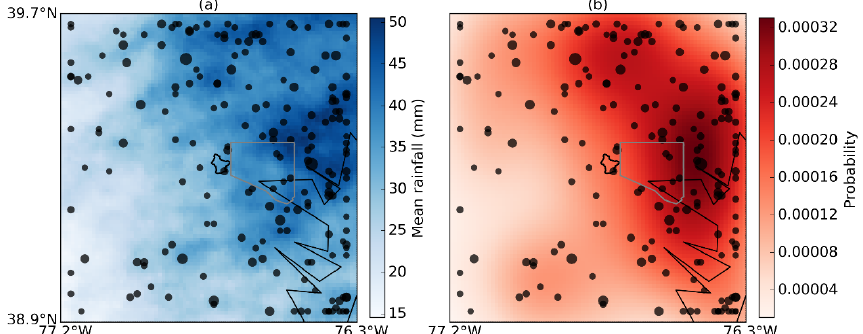
Figure A1. Maps of mean storm total rainfall (a) and probability of storm occurrence (b) for the 200 storms in the 3h storm catalog. (The black dots indicate the locations of rainfall centroids.)